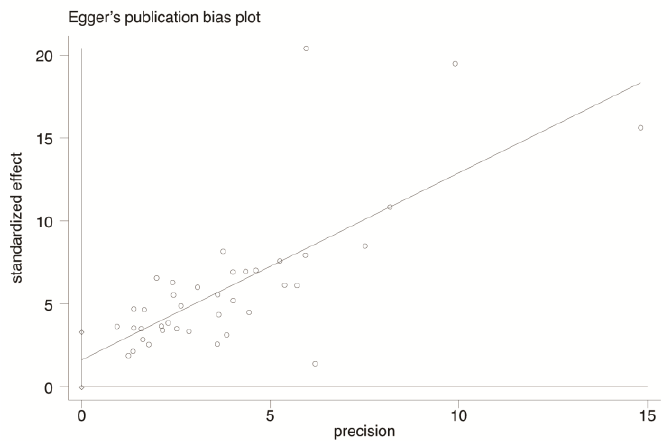
Figure 5. Funnel plot analysis of noise exposure and risk of HFNIHL.